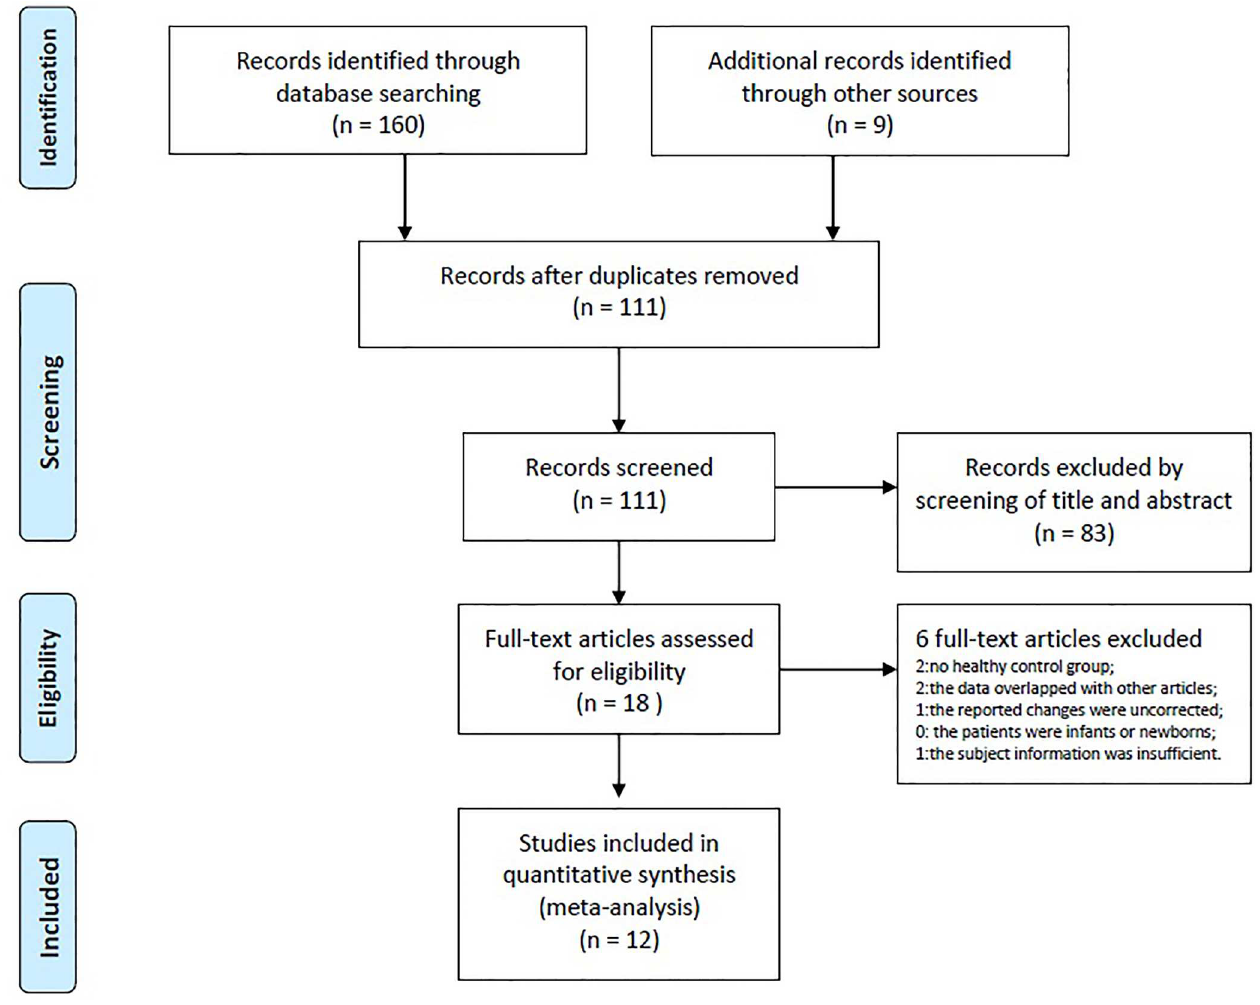
Fig 1. Flow diagram of studies included in the current